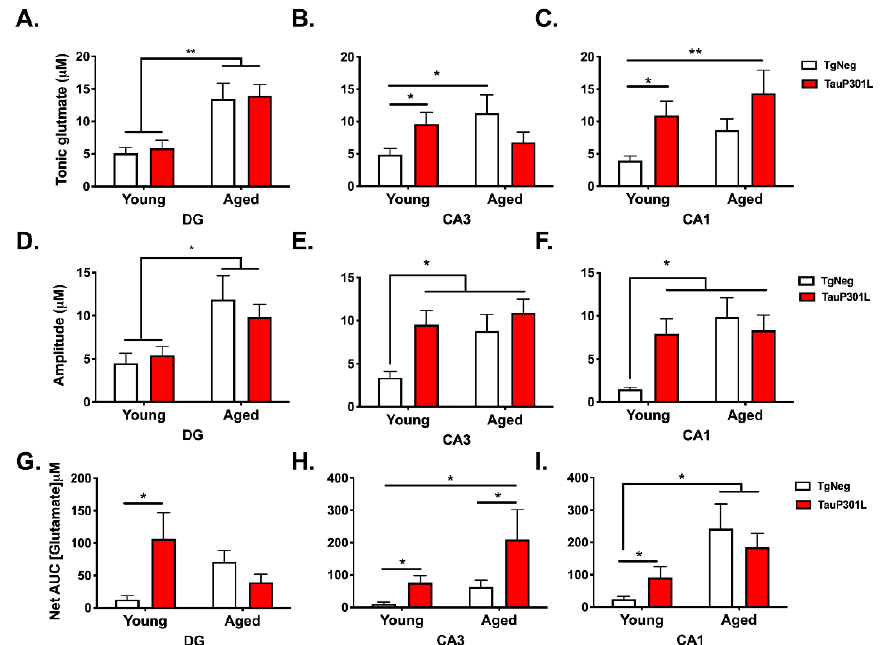
Figure 4. Age- and tau-associated changes in glutamate neurotransmission. Age and P301L tau ex- pression resulted in alterations in measures of tonic, resting glutamate ( A – C ), KCl-evoked glutamate release ( D – F ), and glutamate uptake ( G – I ) in a subregion-dependent manner. * p < 0.05; ** p < 0.01; n = 8 – 13/group.